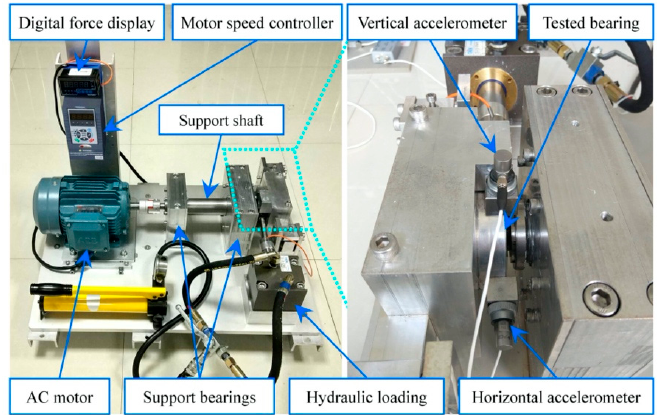
Figure 3. Layout of the test rig used for accelerated failure.